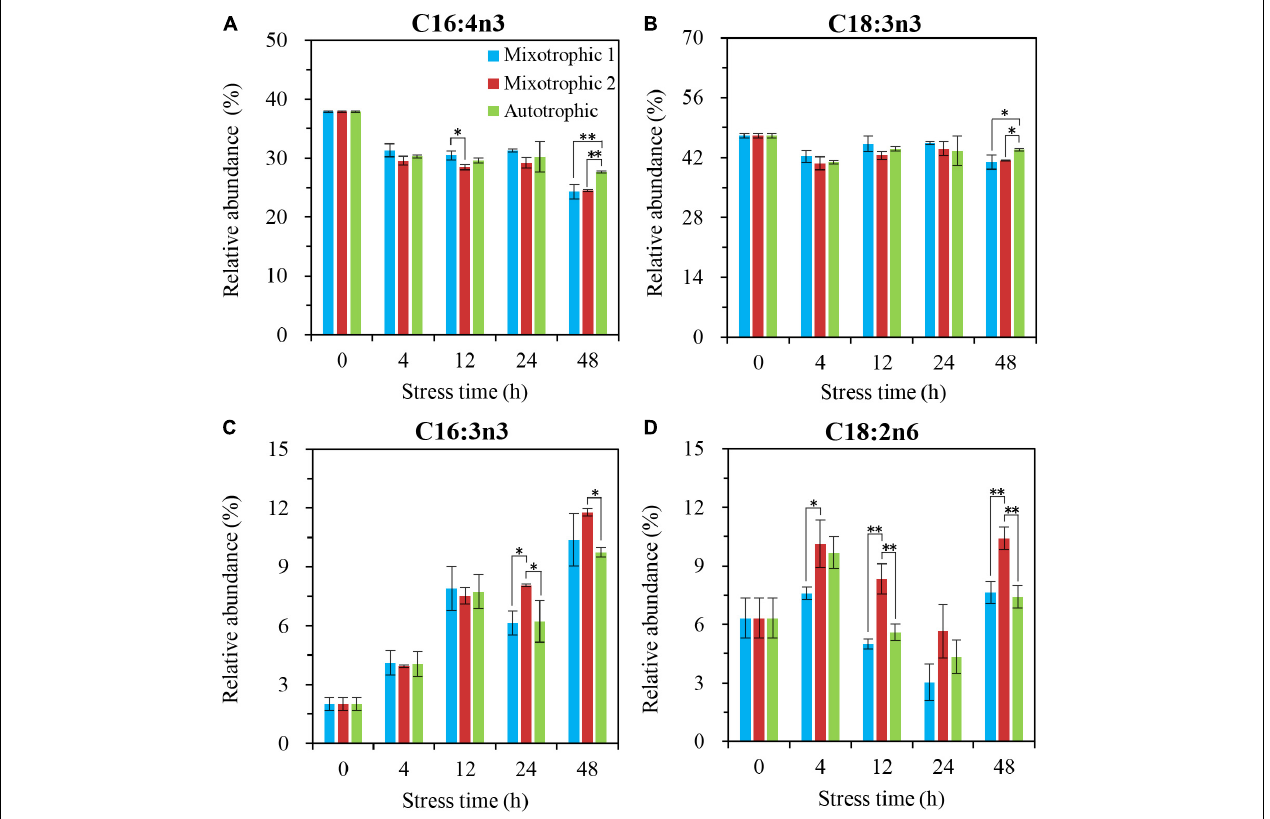
FIGURE 8 | Time course of changes in the relative abundances of the major fatty acyls in MGDG of C. reinhardtii BAFJ5 under three carbon supply regimes over 48 h of HL-N. The carbon supply regimes for mixotrophic 1, mixotrophic 2, and autotrophic were 17 mM acetate and 2% CO 2 (v/v), 17 mM acetate and ambient 0.04% CO 2 (v/v), and 2% CO 2 (v/v), respectively. Cx:ynz, where x, y, and z refer to the number of carbon, the number of double bonds, and the position of the first double bond counting from the methyl end, respectively. Values are the means of three independent replicates ± SD ( n = 3). ∗ p < 0.05; ∗∗ p < 0.01.